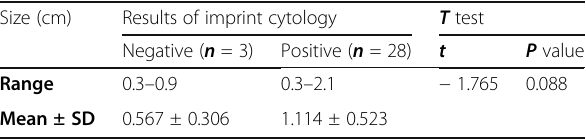
Table 5 Relation between the size of the biopsy specimen and the sensitivity in the bronchoscopic group Size (cm) Results of imprint cytology